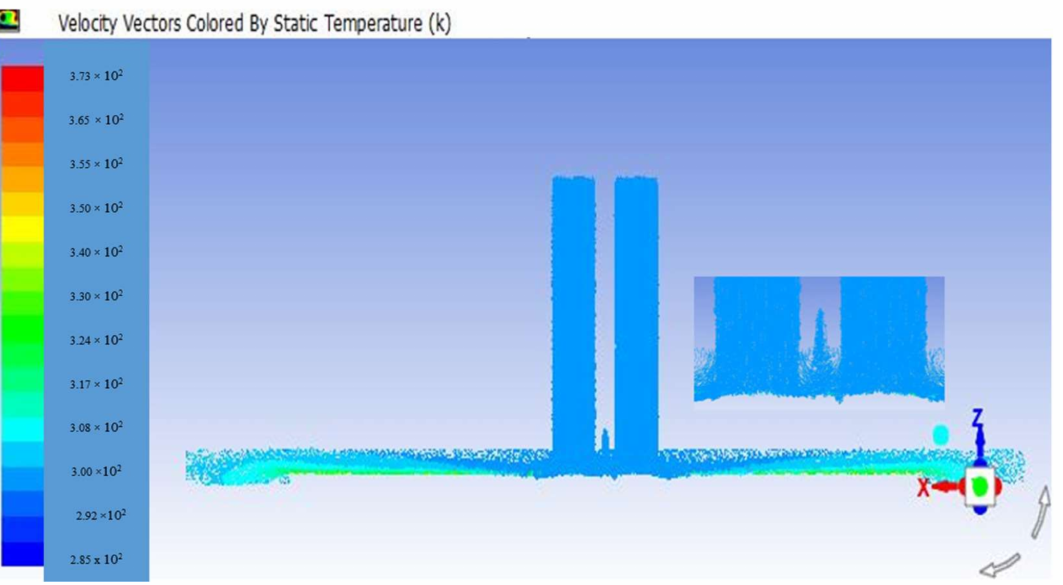
Figure 12. Velocity vectors colored by the static temperature of the twin impingement jet mechanism at the Nozzle-Nozzle spacing equal to 1 cm and the Nozzle-Plate distance equal to 1 cm.